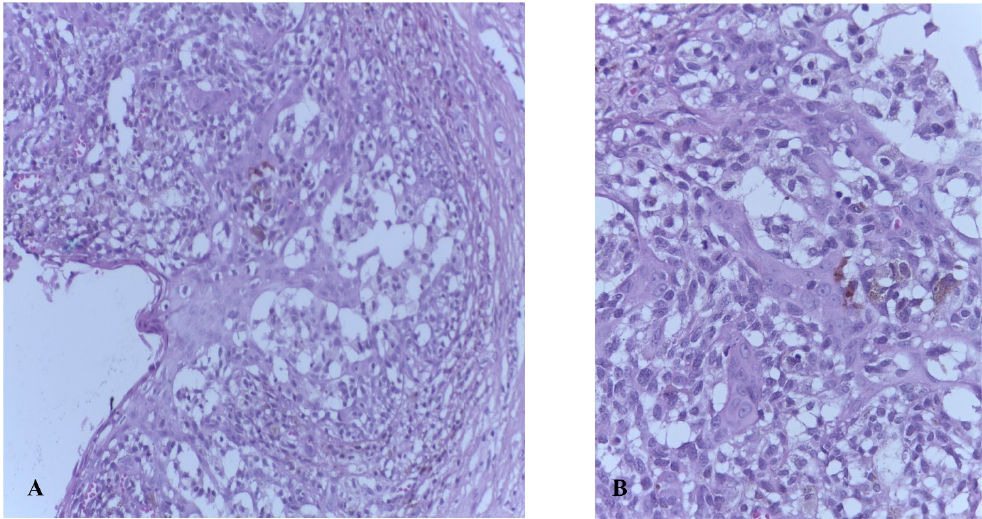
Figure 4. ( A ) Vaginal melanoma. Tumor cells organized in nests, some fusiform-looking cells (Hematoxylin-eosin stain, original magnification × 10.) ( B ) Vaginal melanoma. Epithelioid-looking malignant cells in lamina propria outlooking a nest disposition, abundant eosinophilic cytoplasm. Hematoxylin-eosin stain, original magnification × 20 (histological image courtesy of dr. Ileana Popa).